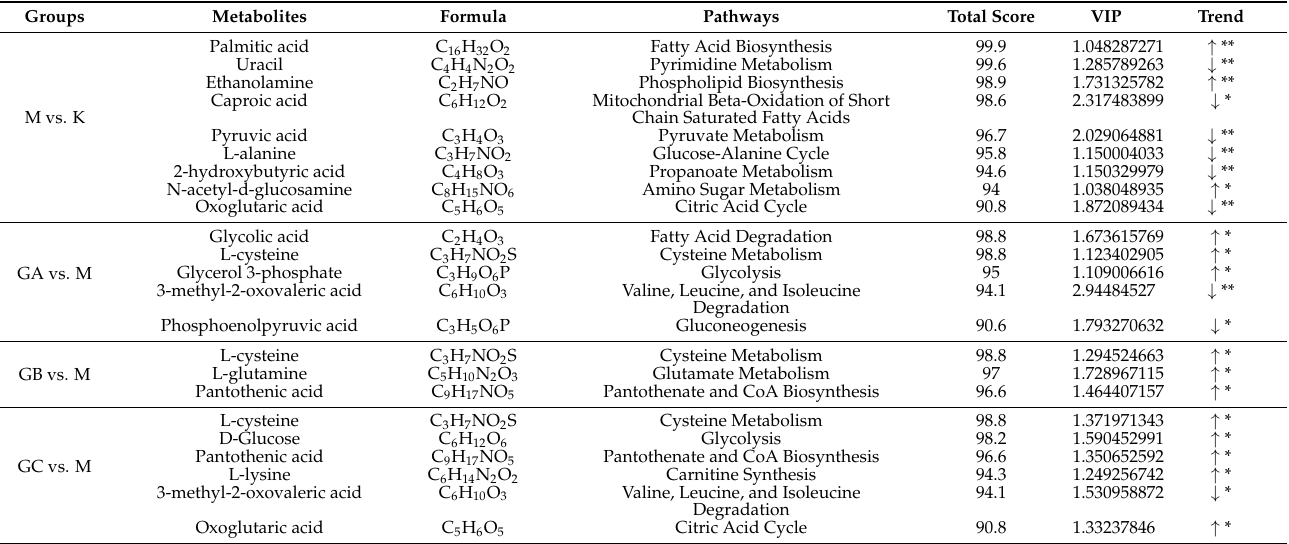
Table 2. Differential metabolites among treatment